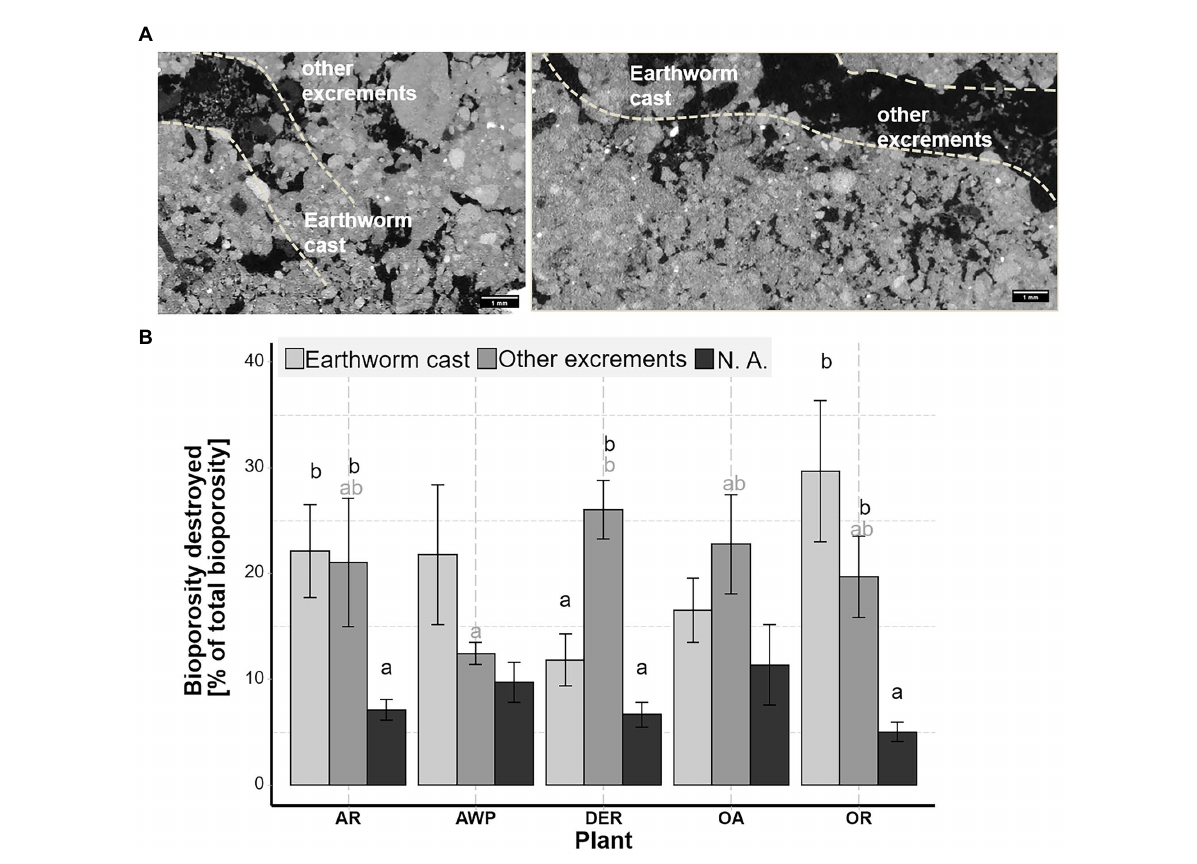
FIGURE 6 Destroyed bioporosity through earthworms, mesofauna and other causes (e.g., by internal erosion). (A) Shows X-ray CT image slices of biopores filled by earthworm and mesofauna cast. Distribution of destroyed biopores by different causes for the five different cover crops expressed as percent of the total bioporosity. (B) Whiskers show standard error of the mean. Black letters indicate significant differences between the three components for each plant, while significant plant effects are indicated by the gray colored letters (only significant for other